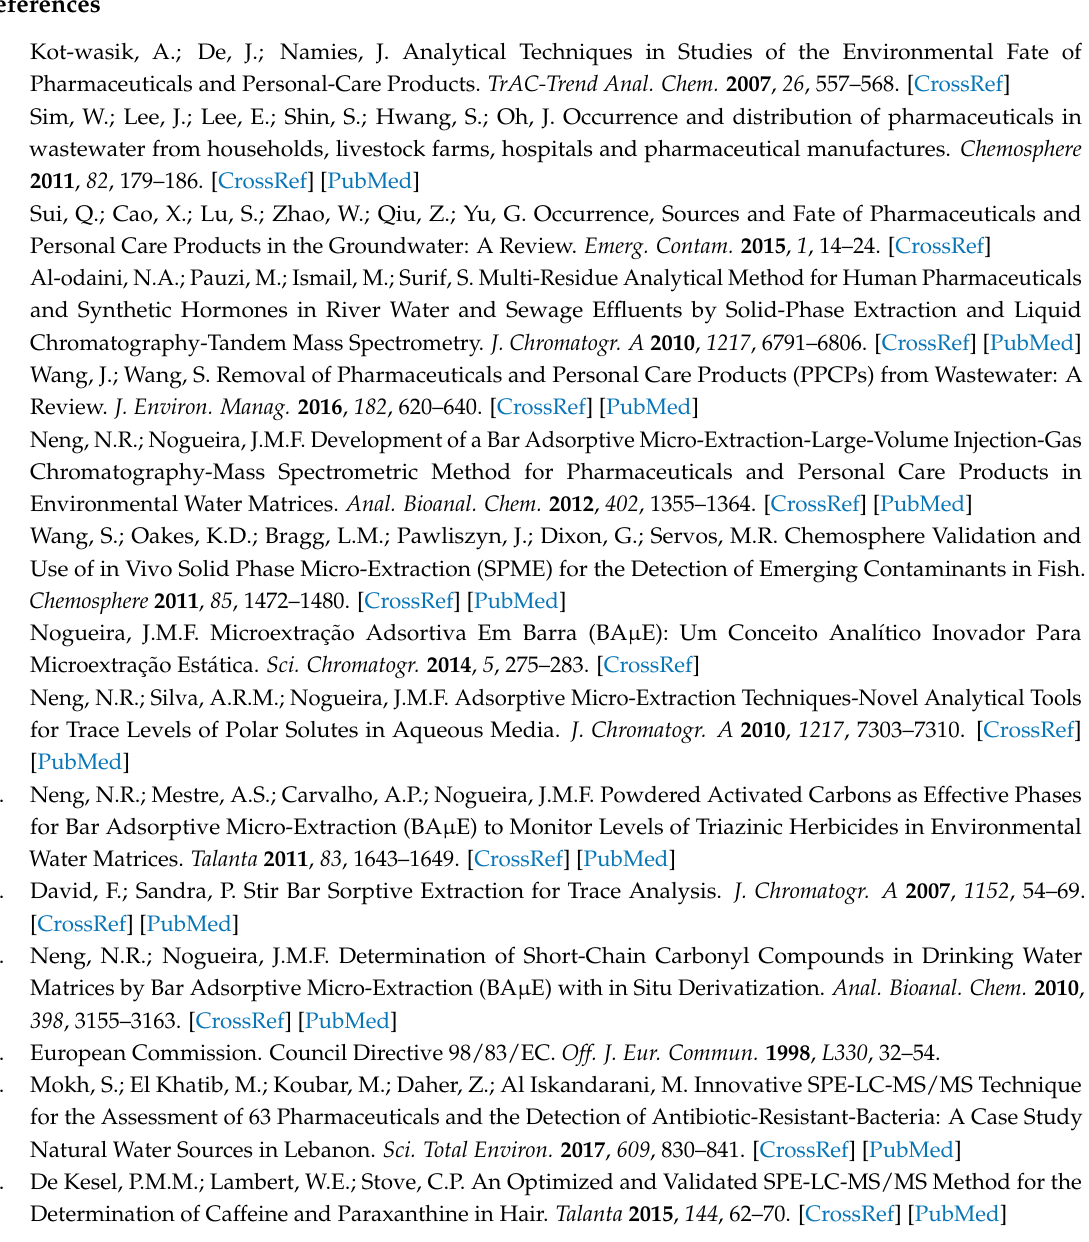
Supplementary Materials: The following are available online. Table S1. Nanotextural and chemical characteristics of the commercial ACs. Figure S1. Effect of matrix polarity (a) and ionic strength (b) on the recovery of ACF and CAF by MSA µ E(AC(R)-LD/HPLC-DAD. Figure S2. Evaluation of extraction capacity after immersing the devices in different